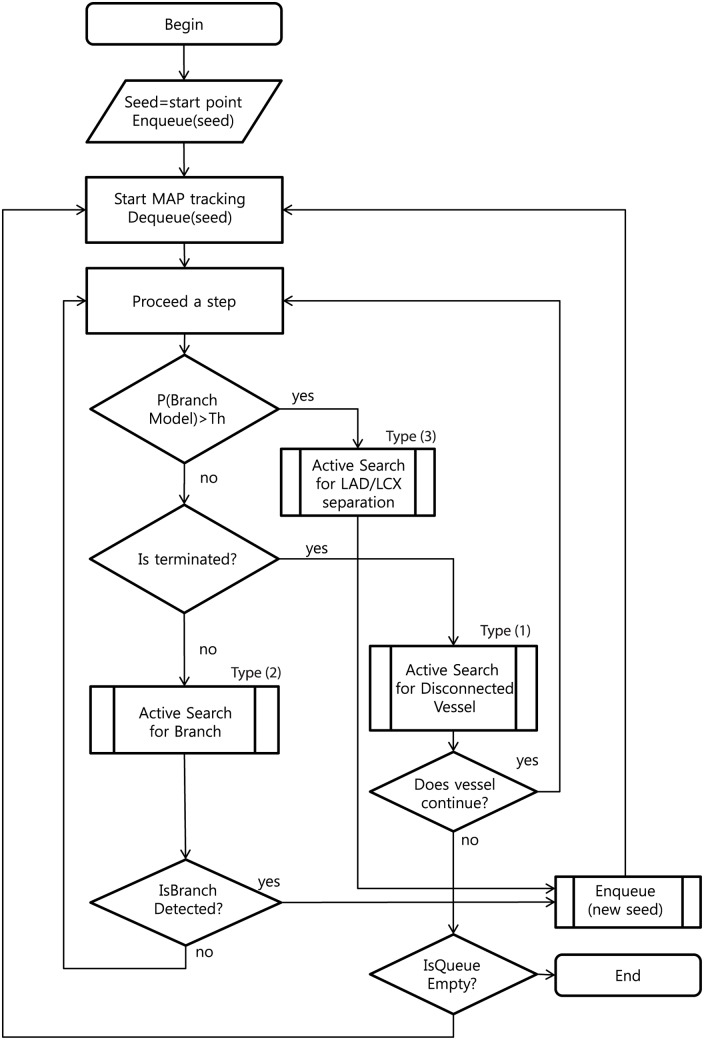
System workflow.